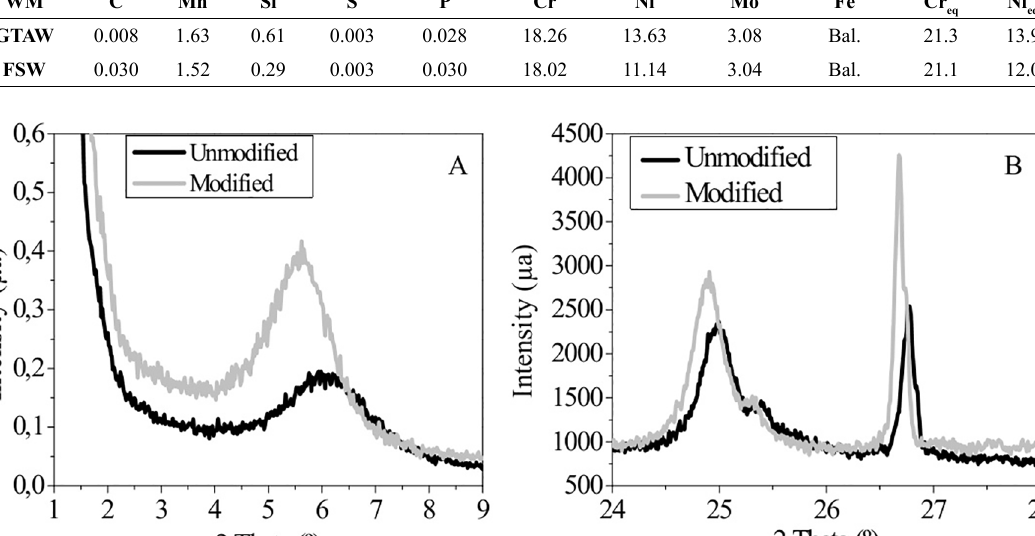
Figure 2. Equilibrium phase volume fractions as function of temperature determined by computational thermodynamics: (a) GTAW; (b)